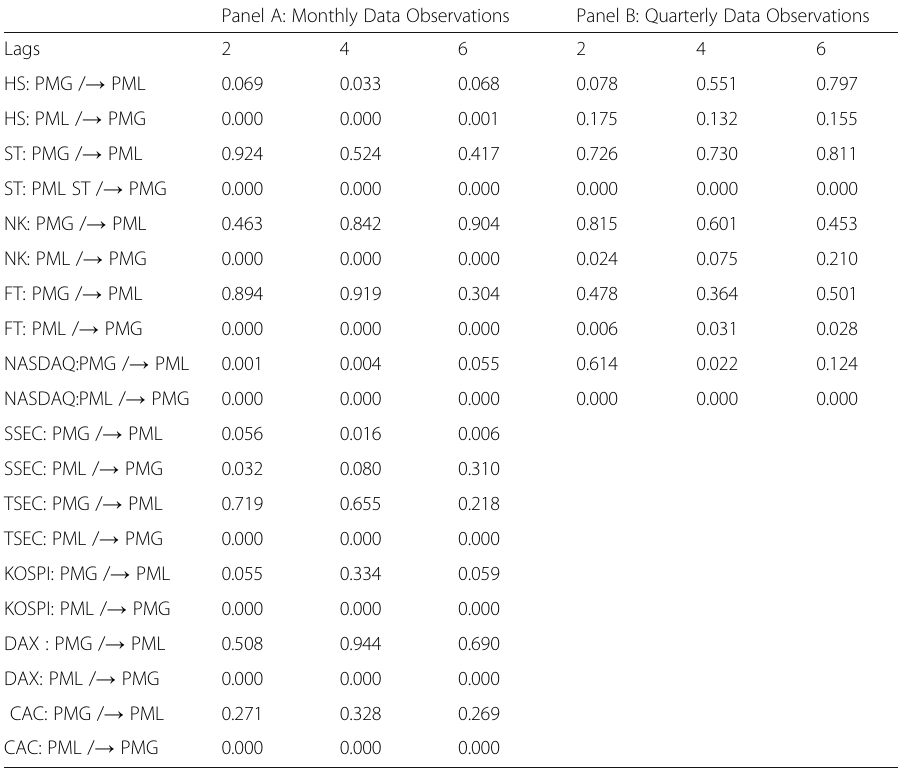
Table 18 Granger Causality Tests on PMG and PML: Decomposition with High Price Extremes Panel A: Monthly Data Observations Panel B: Quarterly Data Observations